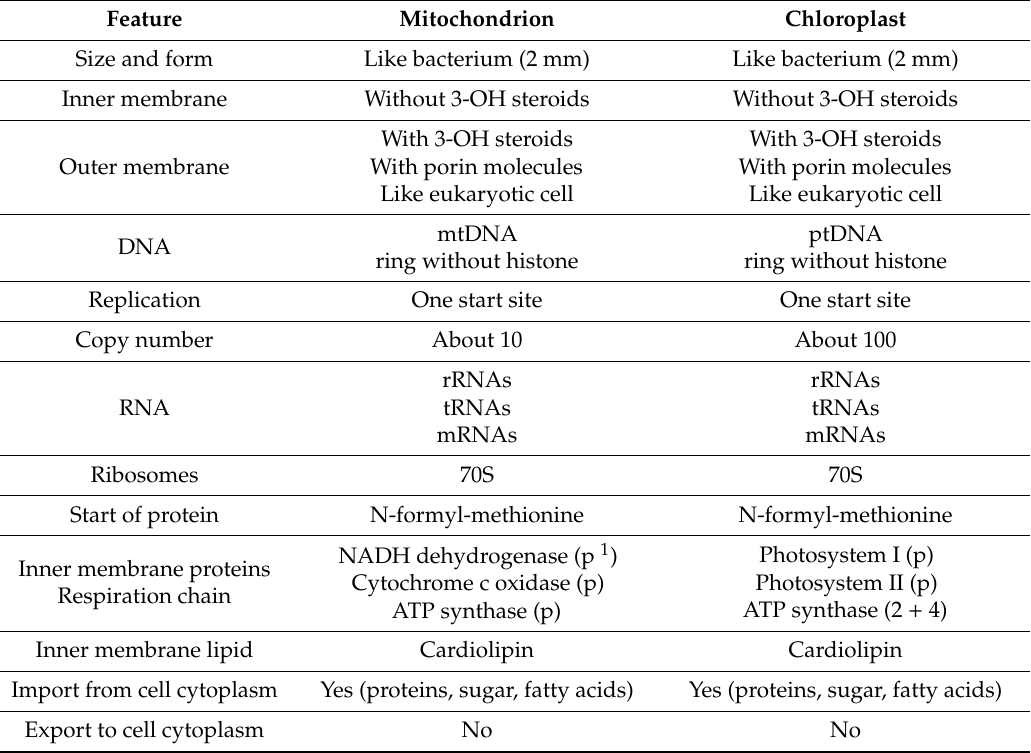
Table 2. Structural features of mitochondria and